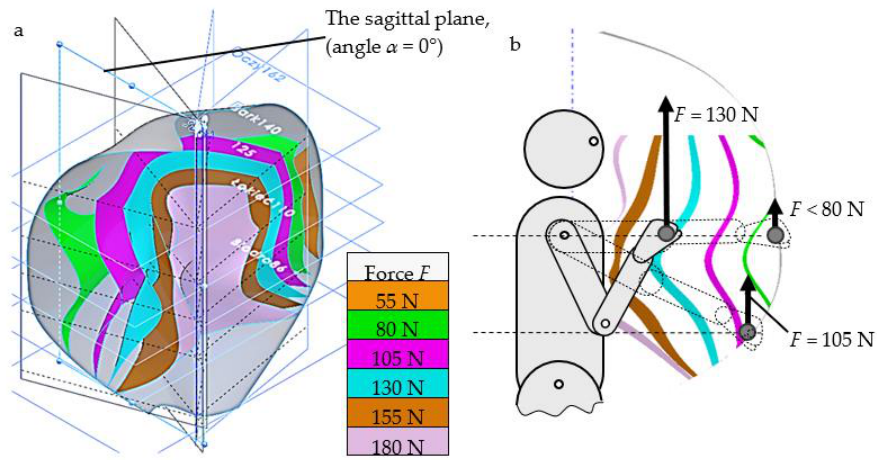
Figure 1. Example model of the individual convenient zone (ICZ) of a particular human, describing range and strength variations of one upper limb (outermost layer represents the range in grey, col- ored layers indicate the strength values that this person can exert upwards): ( a ) Geometric form of strengths and ranges in axonometric projection; ( b ) dimensions of the range zone and strength var- iations of the upper limb in the sagittal plane ( α = 0°).